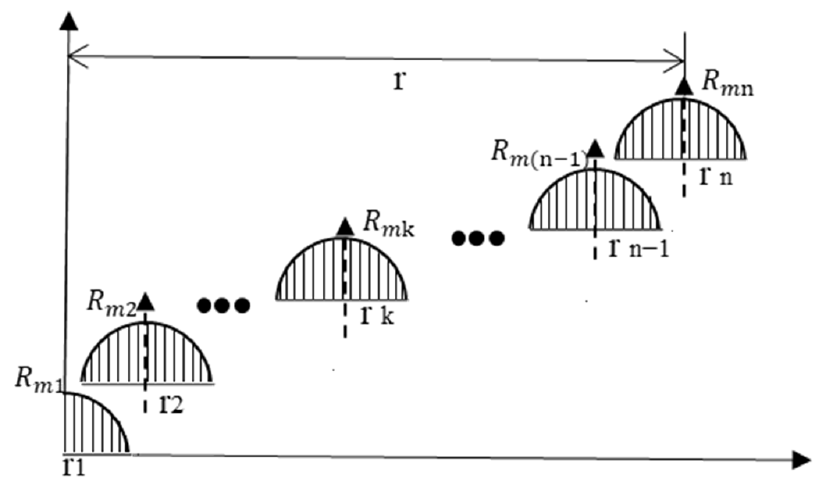
Figure 4. Sketch of the superposition of the discrete TIF at each sample point.